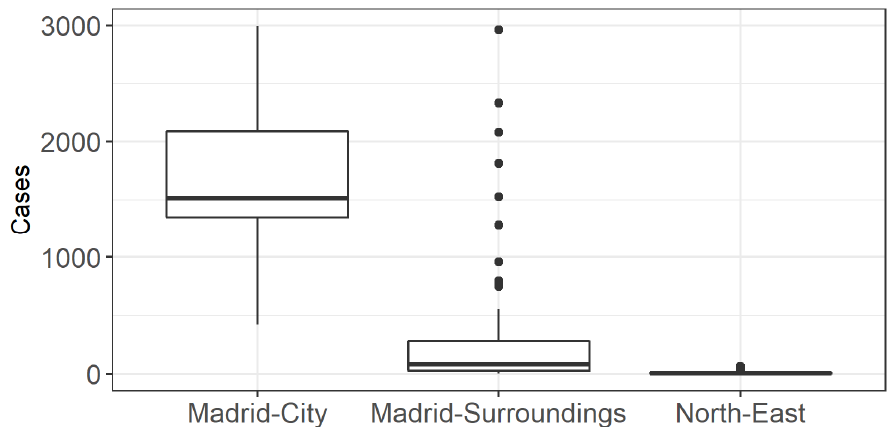
Figure 3. Boxplot of COVID-19 cases by cluster. The diagram represents the median value (line inside the box), the Q1 (lower boundary of the box), the Q3 (upper boundary of the box), the maximum and minimum (vertical line) and the outliers (the dots).